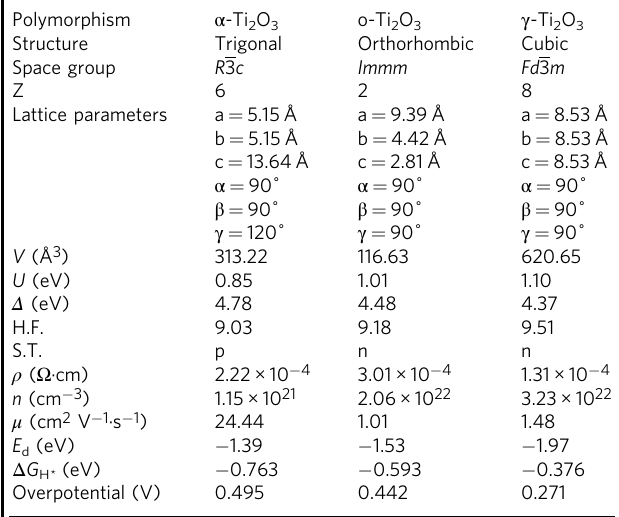
Table 1 Summary of the parameters of Ti 2 O 3